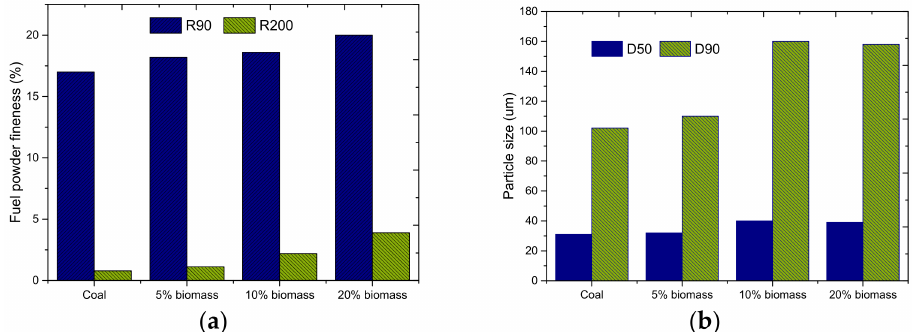
Figure 5. Particle sizes at different biomass co-firing ratios; ( a ) fuel fineness %, and ( b ) average particle